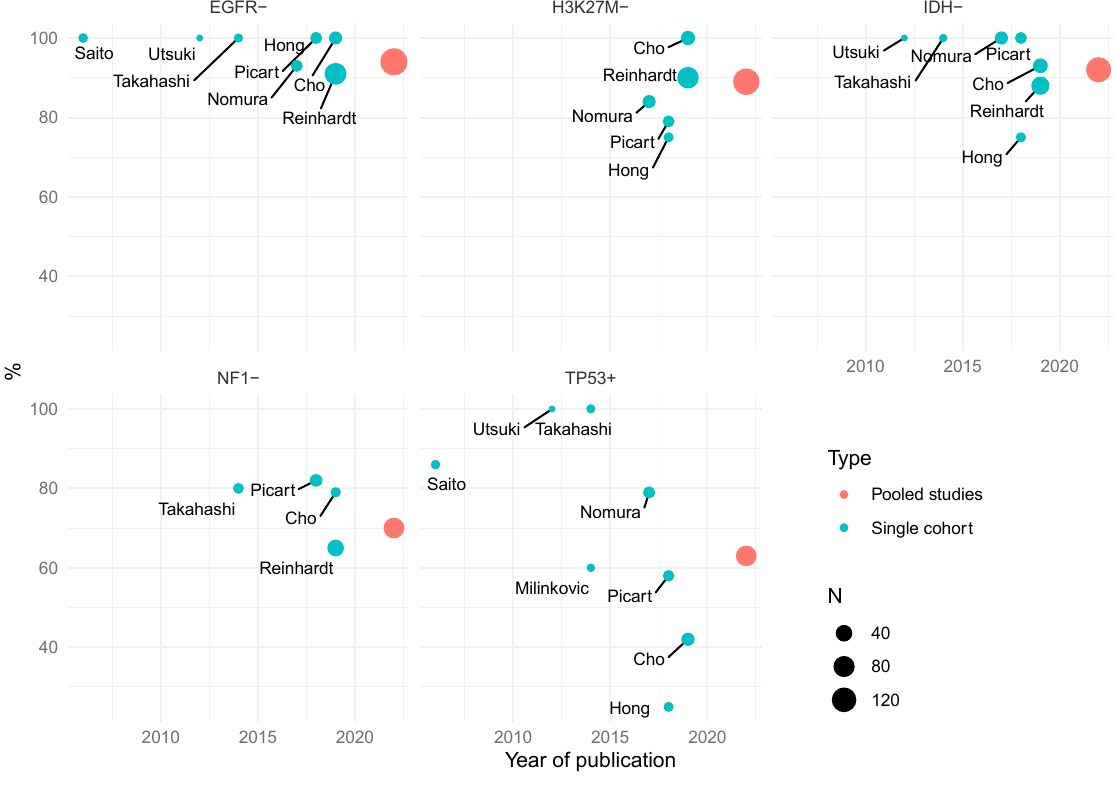
Figure 2. Frequency of gene alteration in cerebellar high-grade glioma. Reports (blue) are identified by first author and plotted by both publication date and the percentage gene prevalence in the respective cohorts. For each gene, a pooled average (red) of the reports is given at year 2022. Cohort size is represented by circle size. N = number of patients.